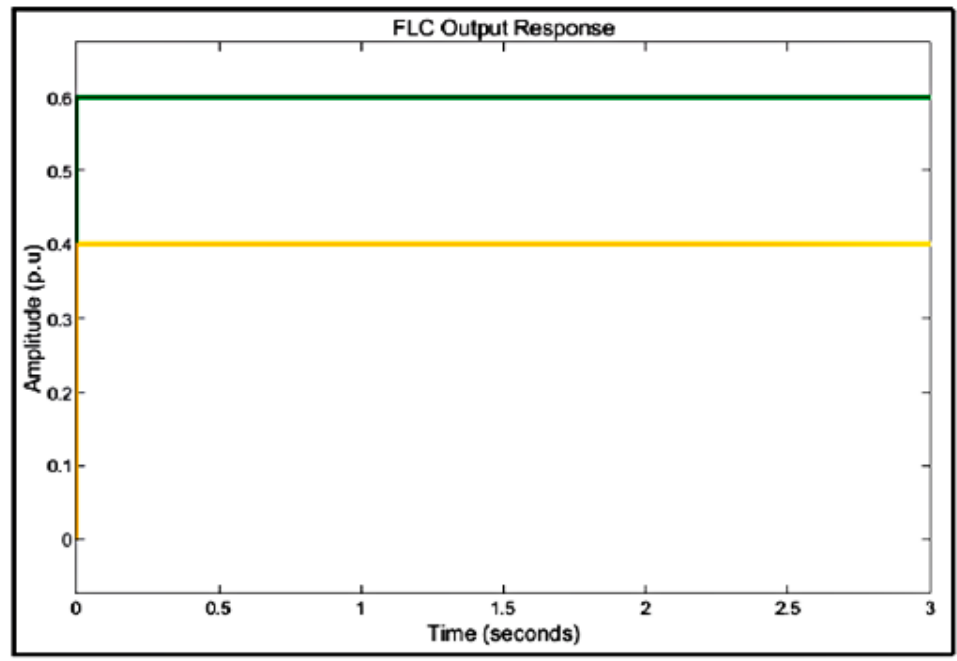
Figure 13. FLC output response during CCC demand for cases one and two.